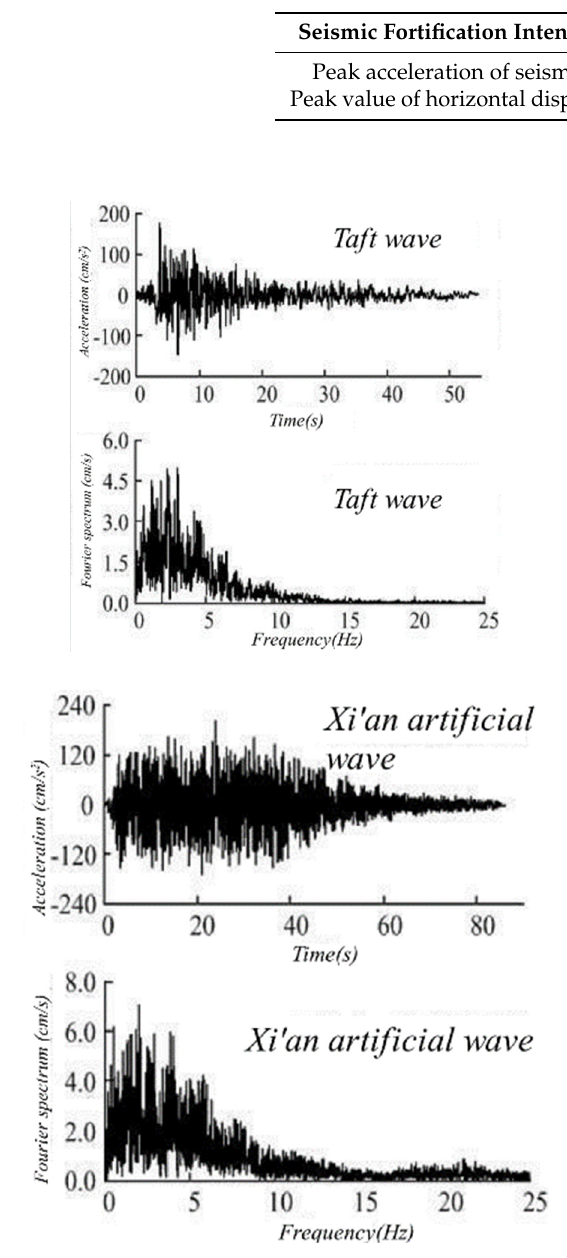
Figure 7. Acceleration and Fourier spectra of input ground motion. Table 1. Maximum free ‐ field horizontal displacement.